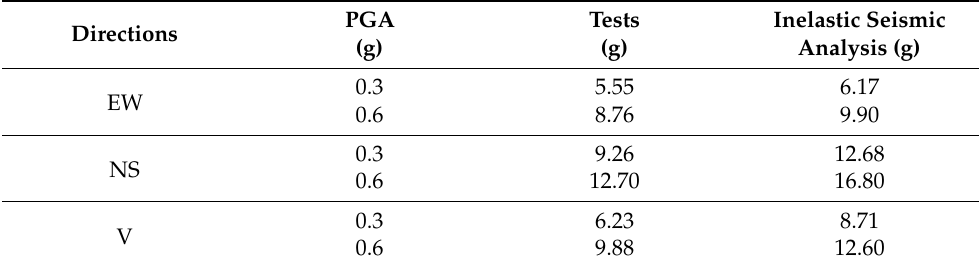
Table 11. Comparison results of ZPA responses at the pipe end (Accelerometer-3).